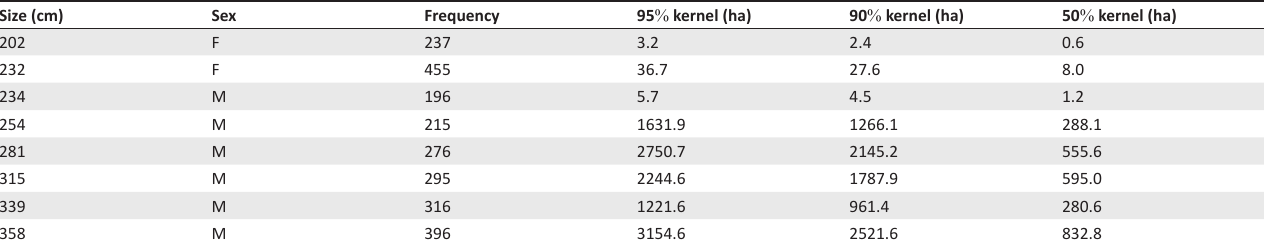
KDE, kernel density estimates. FIGURE 3: Home range of Nile crocodiles at Ndumo Game Reserve where a. is mean (+ standard error) home range (95 % kernel density estimates) of sub- adults ( n = 3) and adults ( n = 5); and b. is mean (+ standard error) core home range for adults ( n = 5) and sub-adults ( n = 3) with ± 95 % confidence intervals. TABLE 2: Home range estimates for 8 Nile crocodiles (202 cm – 358 cm total length) in Ndumo Game